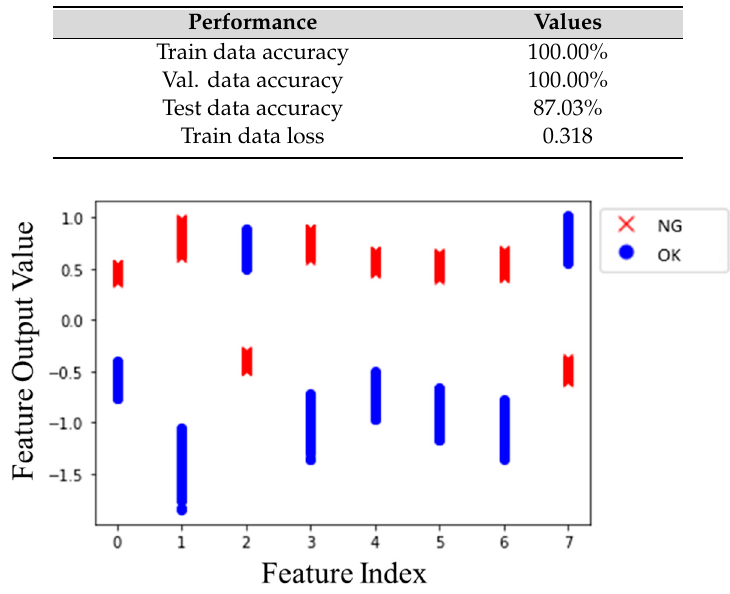
Figure 17. Feature clustering chart.